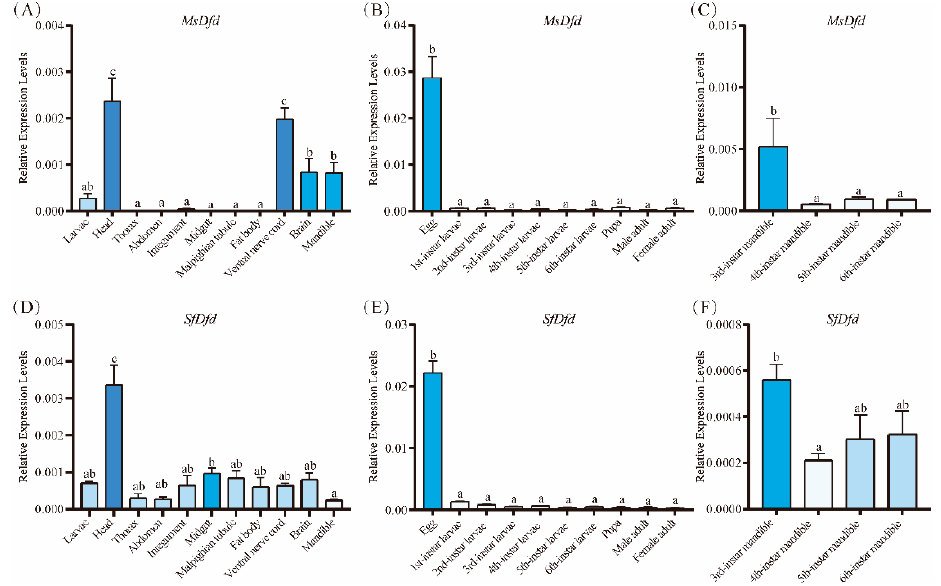
Figure 4. Spatiotemporal expression patterns of MsDfd and SfDfd . ( A ) MsDfd in different tissues of 4th-instar M. separata . ( B ) Levels of MsDfd during different developmental stages of M. separata . ( C ) Expression of MsDfd among mandibles of 3rd–6th instar M. separata . ( D ) SfDfd in different tissues of 4th-instar S. frugiperda . ( E ) Levels of SfDfd during different developmental stages of S. frugiperda . ( F ) Expression of SfDfd among mandibles of 3rd–6th instar S. frugiperda . The 2 −Δ Ct method was used to calculate the relative gene expression. Three biological replicates were performed for each group. The bars with different colors and different numbers on the columns represent significantly different levels of gene expression ( p < 0.05, Duncan’s multiple range